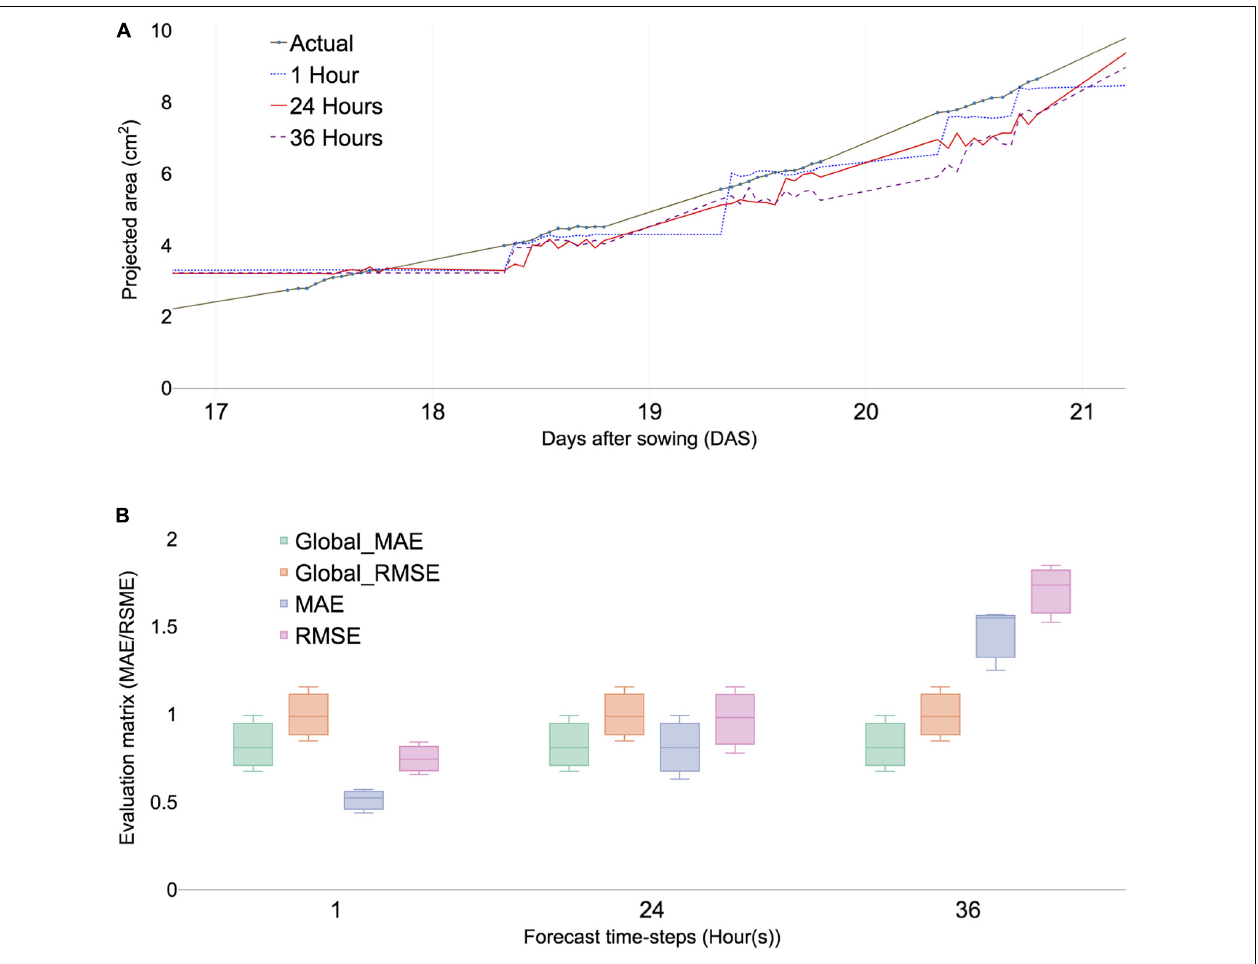
FIGURE 3 | Predicted PA and error calculation at 1-, 24-, and 36-h forecast window sing ML algorithms (XGBoost). (A) Comparing PA prediction with 17–21 DAS of ID 98. (B) Comparing evaluation matrices of mean absolute errors (MAE), root mean square error (RMSE) of three selected samples, namely, ID 98,100, and 103. Global MAE and RMSE are defined as average MAEs and RMSE of all forecast time